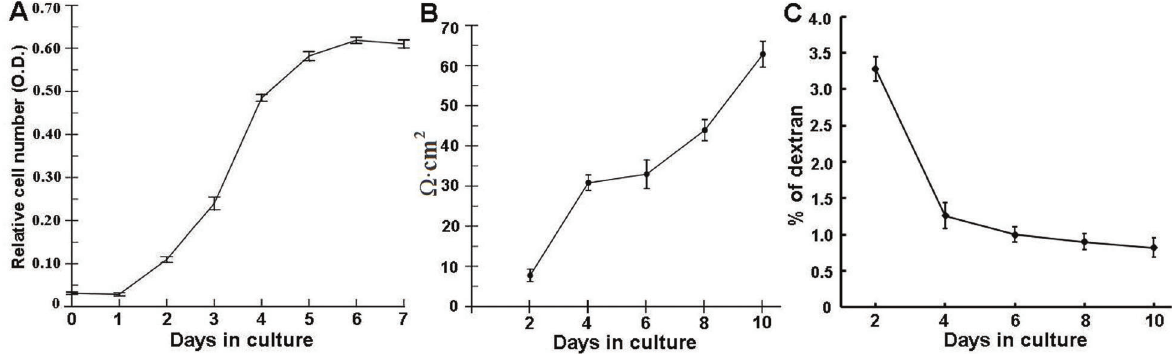
Figure 3. The cell proliferation log phase started after the lag phase of about 2 days with a sharper inclination ( A ). Cells were grown on the apical chamber of transwell-inserts. Transepithelial electrical resistance TEER was measured using an EVOM epithelial volt/ohm meter ( B ). Paracellular permeability was quanti fi ed by apical-to-basal fl ux of 10 kDa FITC-dextran ( C ). All samples were tested in triplicate. Data are reported as means ±